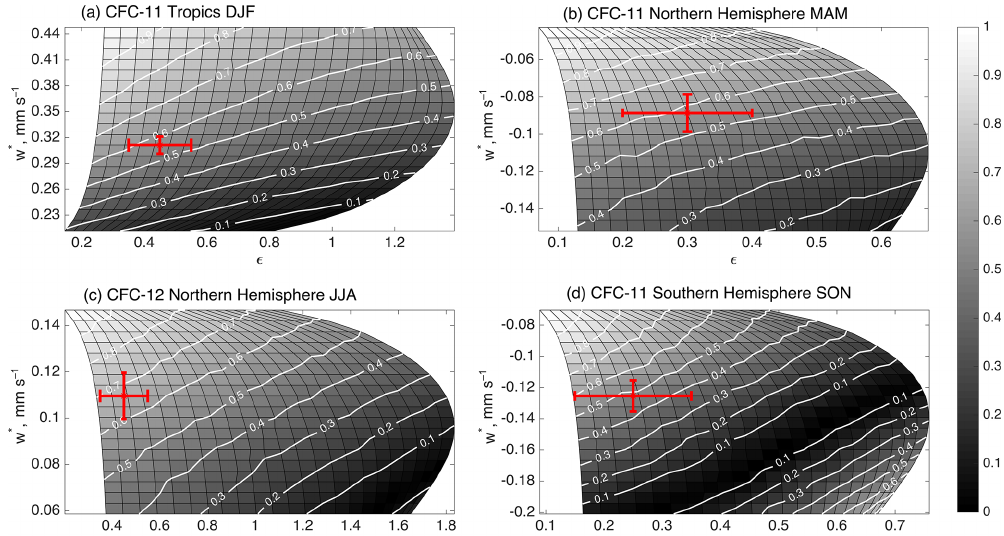
Figure 15. Examples of the TLP comparisons described in the text. The grey scale on each panel indicates the comparison between ACE- FTS and the TLP simulations over various w ∗ ( y axes) and (cid:15) cases ( x axes). The white lines identify the agreement with ACE-FTS (grey colour scale). The red marker indicates the CMAM30HR estimated values of w ∗ and (cid:15) . The examples shown are (a) CFC-11 tropics during the DJF season, (b) CFC-11 Northern Hemisphere during the MAM season, (c) CFC-12 Northern Hemisphere during the JJA season, and (d) CFC-11 Southern Hemisphere during the SON